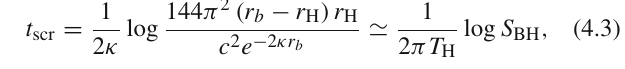
Fig. 3 The free energy F as a function of temperature T H at a 0 = 0 . 5 , 1 , 2. The situation of the Hawking–Page phase structure. The low and high branches correspond to the large and small black